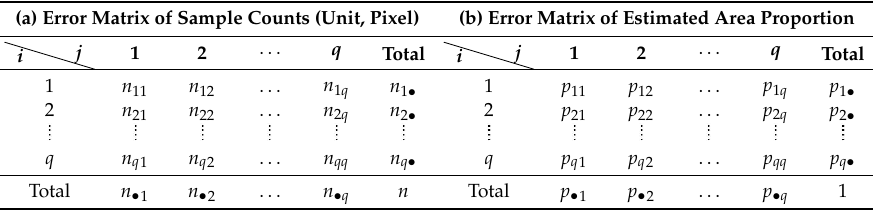
Table 1. Error matrix of sample counts and estimated area proportion.